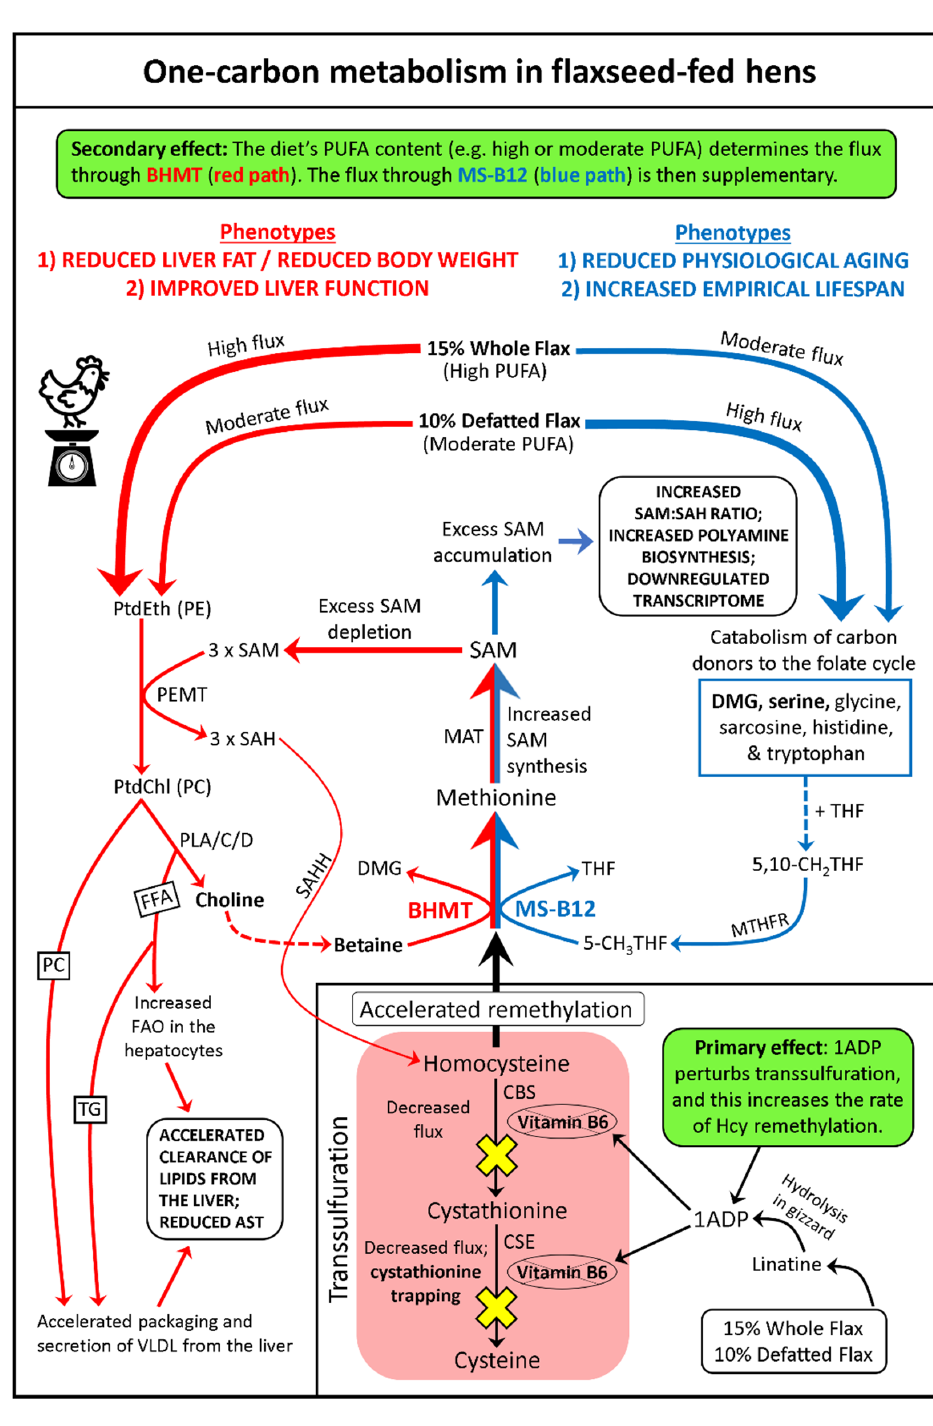
Figure 10. Comprehensive model of one-carbon metabolism in flaxseed-fed hens. The primary metabolic effect (transsulfuration perturbation) is initiated when lADP exerts an anti-vitamin B6 effect that reduces CBS and CSE activity in the liver. This reduces transsulfuration flux and drives accelerated remethylation of Hcy into the Met cycle. This culminates in the increased synthesis of SAM, so that WFX hens and DFM hens have access to excess SAM. The secondary metabolic effect (flux through BHMT) is determined by the PUFA content of the diet, such that WFX hens exhibit a high flux through BHMT, and DFM hens exhibit a moderate flux through BHMT. The high PUFA content of the WFX diet allows WFX hens to strongly hyperactivate PEMT, while the moderate PUFA content of the DFM diet allows DFM hens to only moderately hyperactivate PEMT. In WFX hens, all